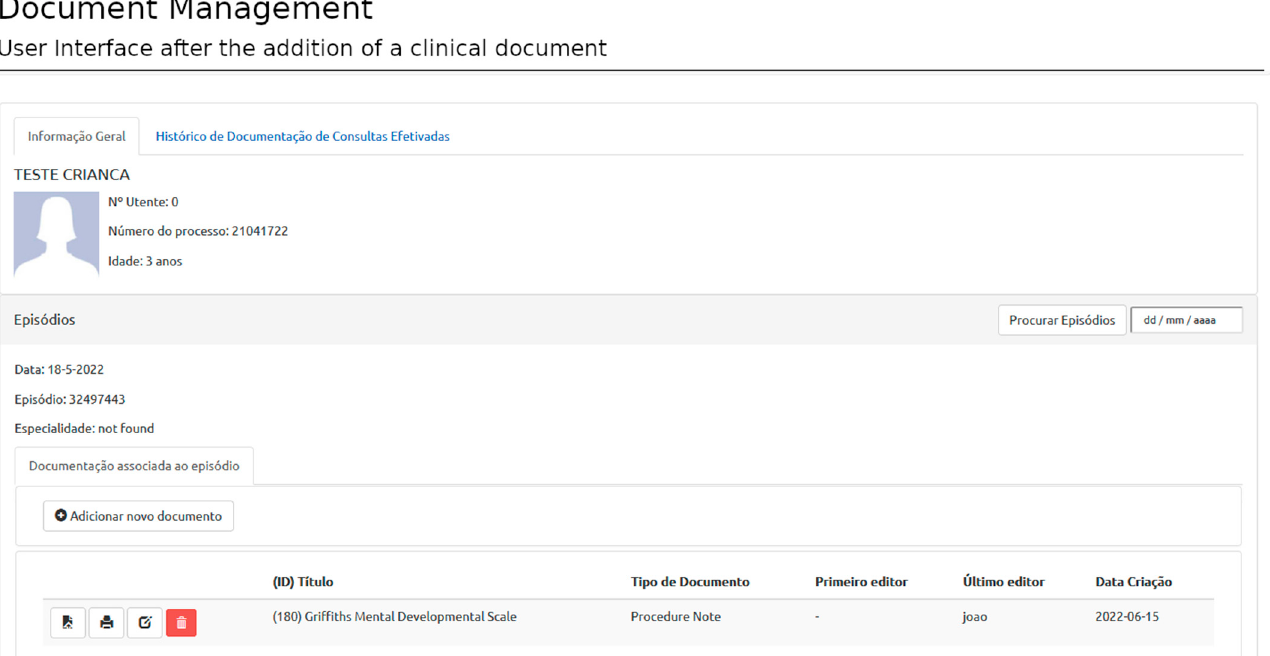
Figure 9. Document Management: User interface after the addition of a clinical document.